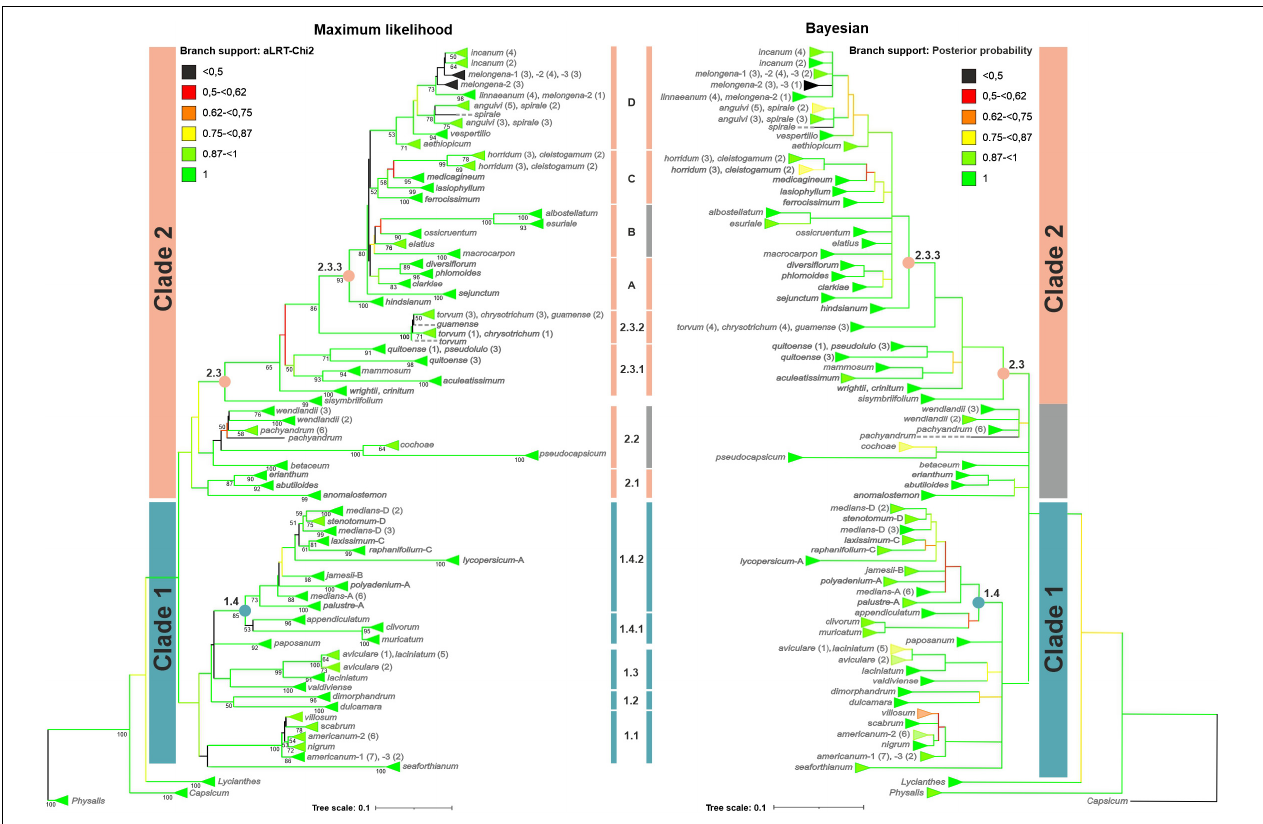
FIGURE 6 | Phylogenetic ML and Bayesian dendrograms constructed by comparison of 5S IGS sequences of Solanum species. The aLRT support and posterior probabilities are represented by different branch colors. Numbers in the ML dendrogram represent bootstrap support values. Terminal clades are collapsed to species level. Numbers in brackets near the collapsed nodes indicate the number of ribotypes used. IGS structural variants A-D are given for members of sect. Petota (Clade 1.4.2). ML clades not confirmed by Bayesian analysis are highlighted in gray